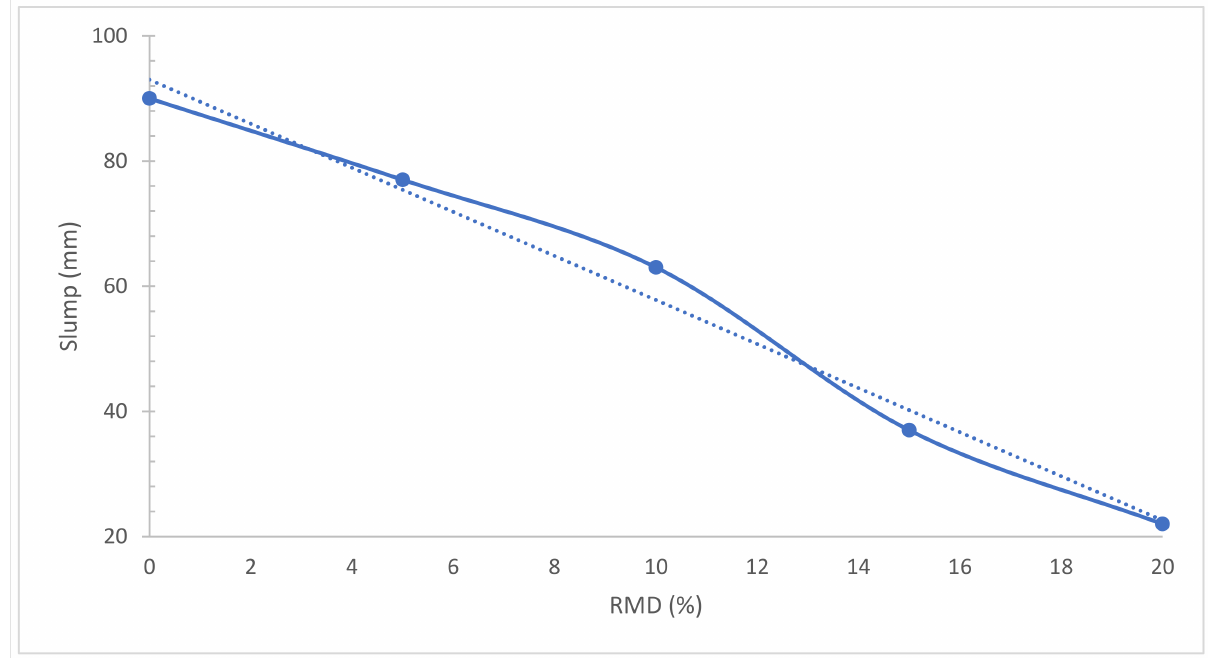
Figure 6. Slump Flow: Data Source